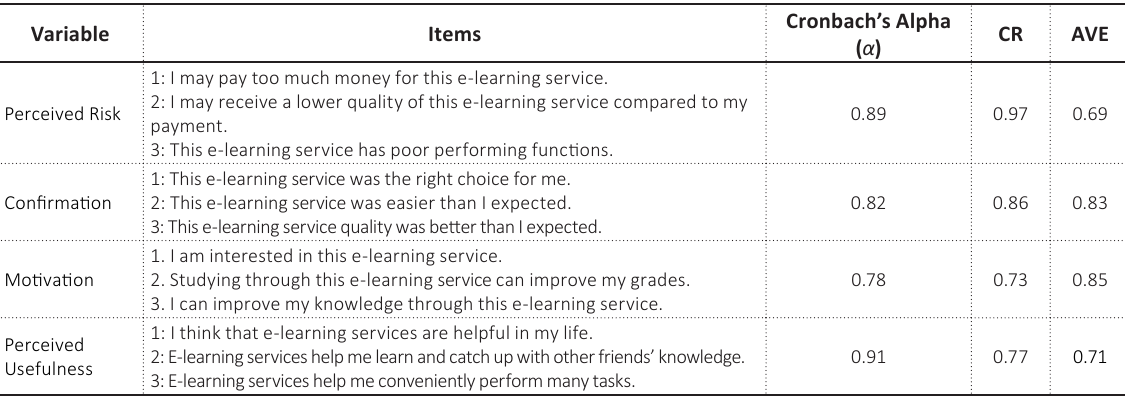
Table 1. Reliability and convergent validity